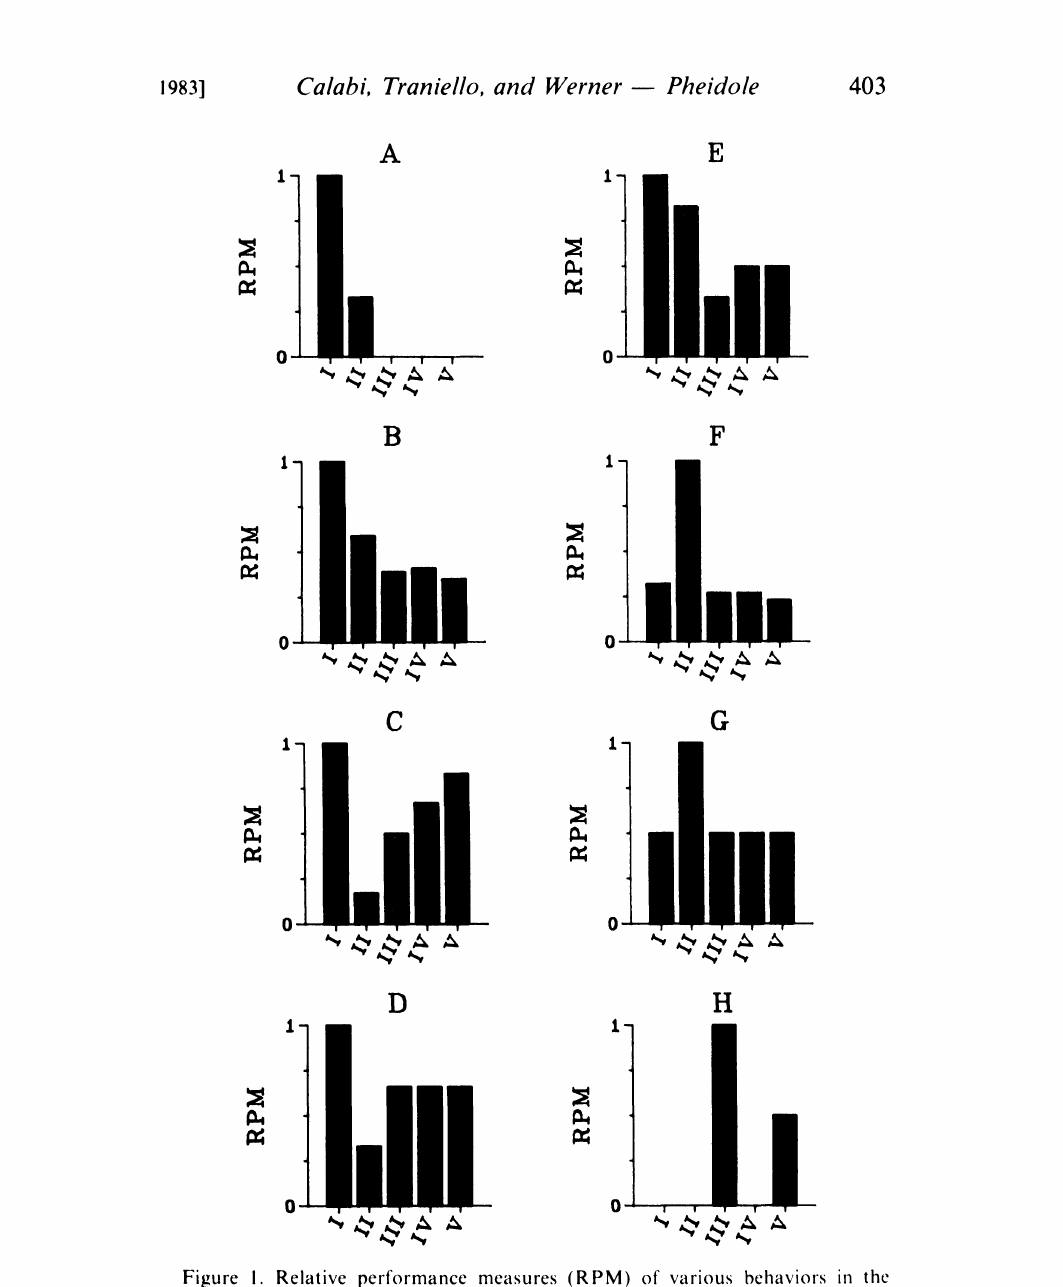
Figure I. Relative performance measures (RPM) of various behaviors in the r, epertories of major (MJ I-M J4) and minor (A-Q) workers of Pheidole hortensis. Roman numerals l-V correspond to worker age classes. Additional details in Materials and